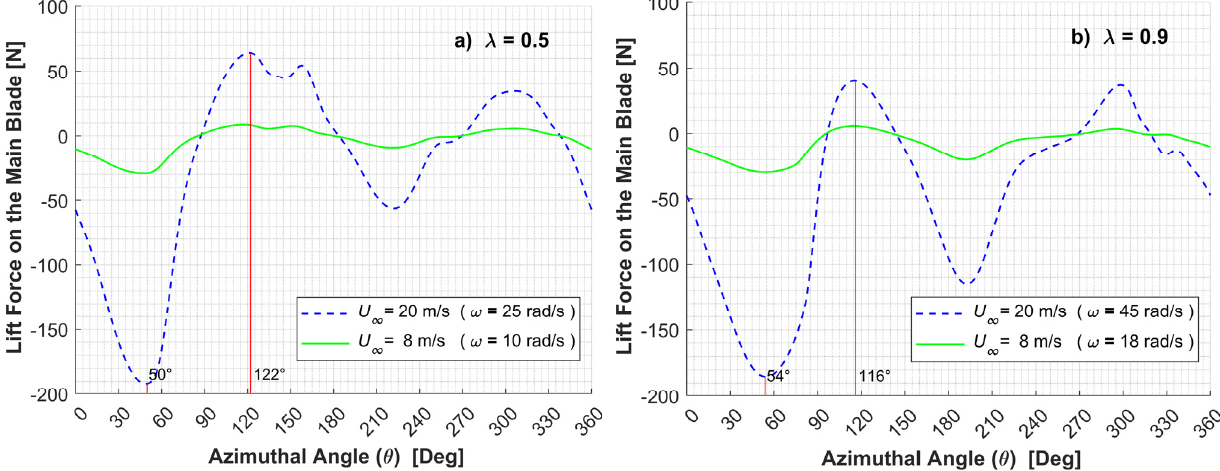
Figure 12. Lift Forces for Blade 1at Various Azimuthal Angles, for U ∞ = 8 m/s and U ∞ = 20 m/s at: ( a ) λ = 0.5 and ( b ) λ = 0.9, Using the 2D Model of the Present Study. Note: The direction of the lift forces is established using as a reference the vertical “y” axis.